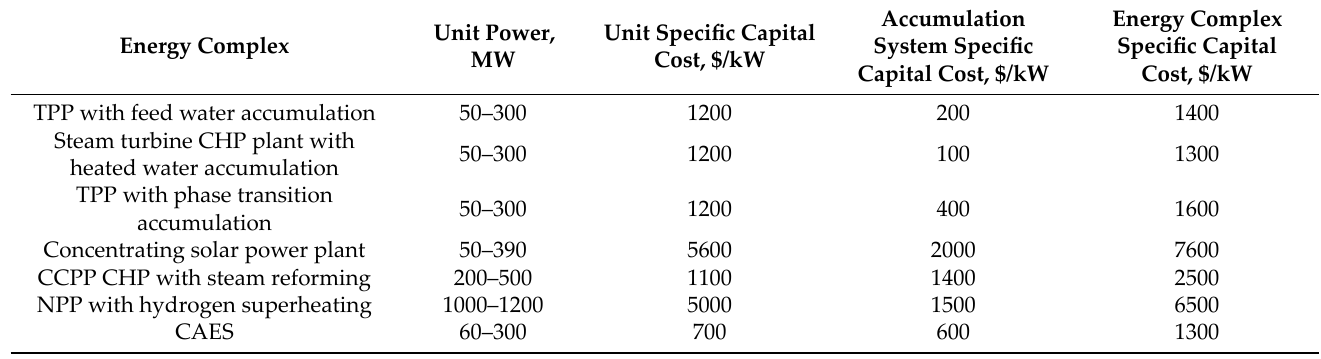
Table 3. Main characteristics of energy complexes with energy storage